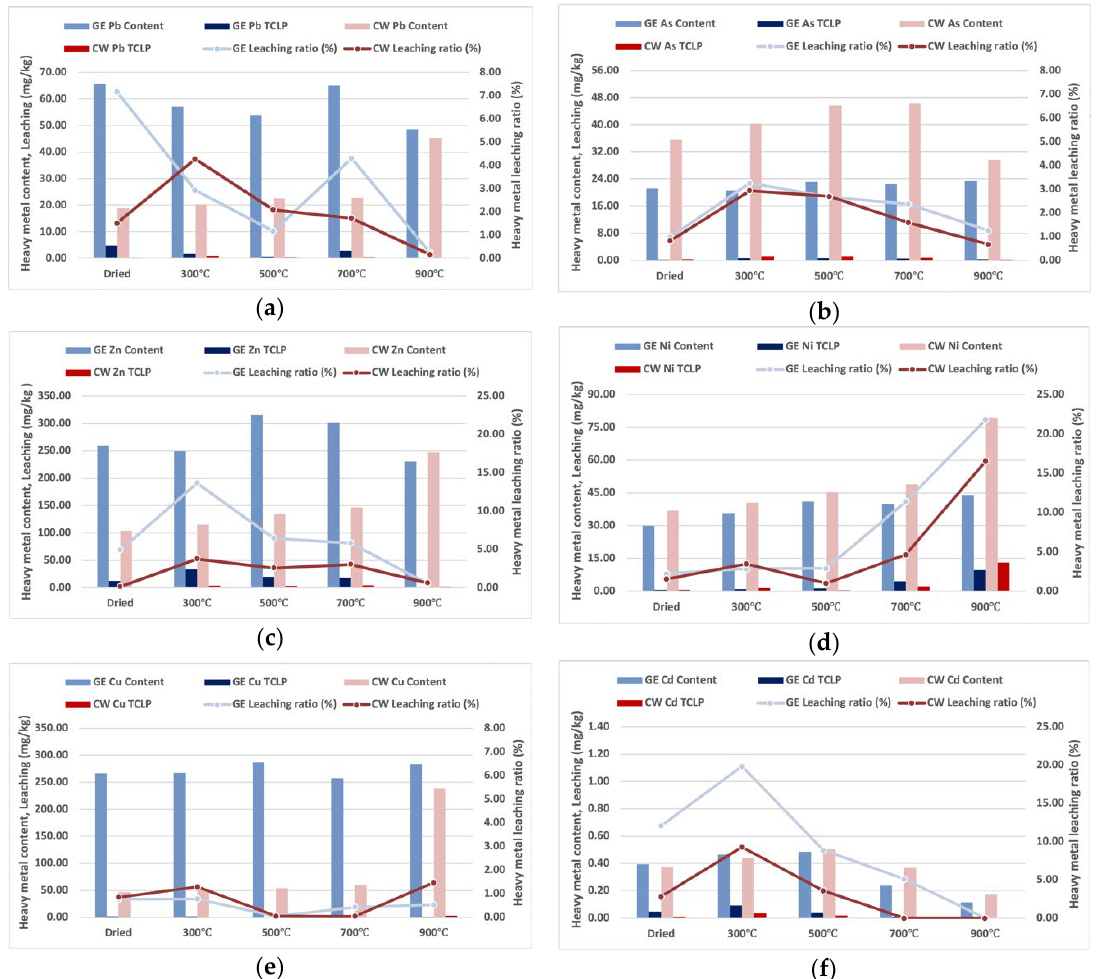
Figure 4. Amounts of heavy metals in biochar according to the pyrolysis temperature: ( a ) Pb; ( b ) As; ( c ) Zn; ( d ) Ni; ( e ) Cu; ( f ) Cd.